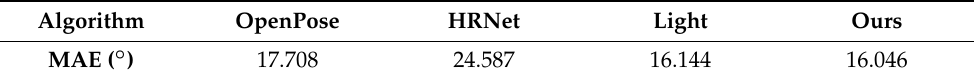
Table 5. The MAE of the elbow angle of different algorithms in the test image